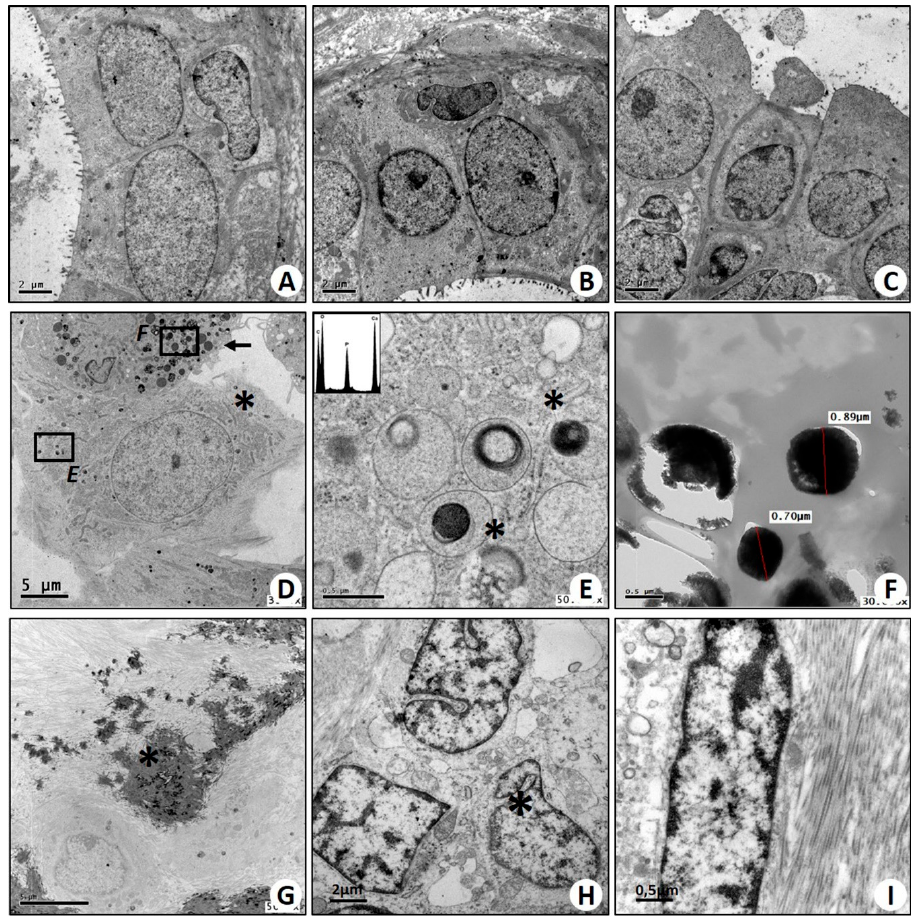
Figure 5. Transmission electron microscopy of breast tissues. ( A – C ) Images show the ultrastructure of normal ducts in adjacent areas of fibroadenoma lesions. Both, myoepithelial and luminal cells are displayed. ( D ) Infiltrating breast cancer characterized by the presence of microcalcifications and vimentin, RANKL, OPN, BMP-2, BMP-4, PTX3-positive cancer cells shows several osteoblast-like cells. Asterisks mark a cell rich in endoplasmic reticulum, large nucleus, and some electron-dense granules. Arrows mark a large cell with numerous electron-dense granules. E and F squares indicate the areas of enlargement of figure E and F. ( E ) High magnification of square E in panel D. Image displays electron-dense granules containing hydroxyapatite (asterisks) (energy dispersive X-ray (Edx) spectrum). ( F ) High magnification of square F in panel D. Image shows fully calcified electron-dense granules. ( G ) Calcified nodule (asterisk) in breast infiltrating carcinoma. ( H ) Several cells surrounding the calcified nodule show large nuclei (asterisk) and collagen fibers both in intracellular and extracellular space. ( I ) High magnification image of a cell next to the calcified nodule in panel G. Electron micrograph shows the presence of fiber collagen in the cytoplasm of this